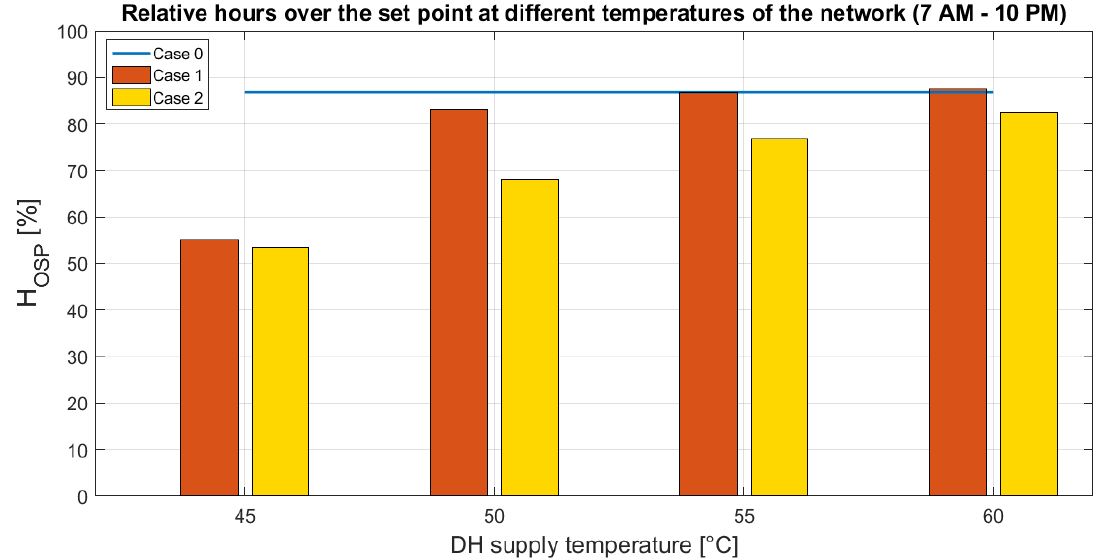
Figure 7. Comparison of annual performance for different supply